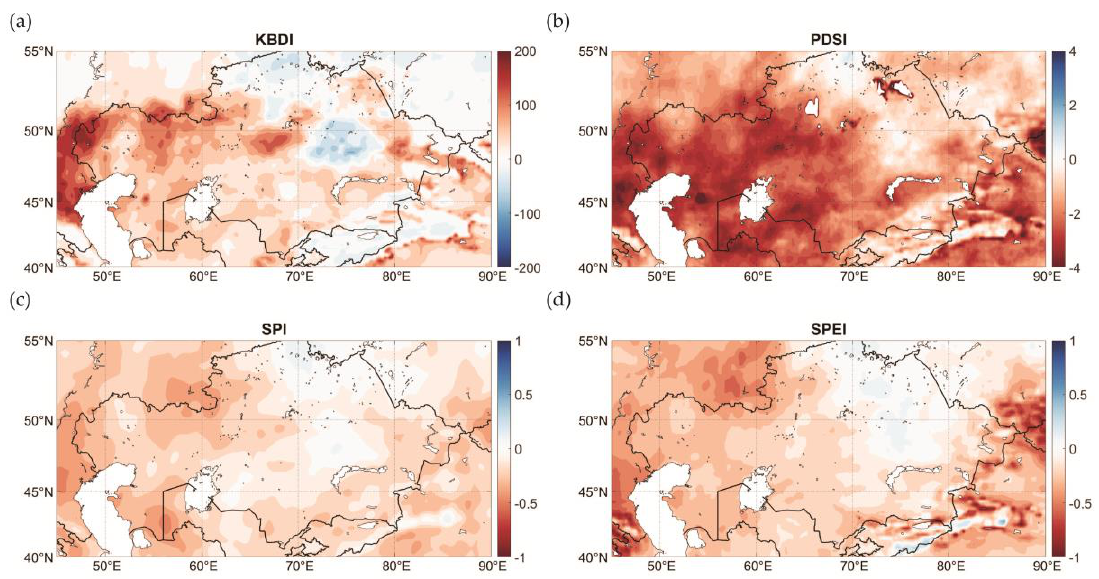
Figure 6. The spatial distribution of the differences between mean KBDI ( a ), PDSI ( b ), SPI ( c ) and SPEI ( d ) averaged over the periods 2001 – 2021 and 1979 – 2000 in summer